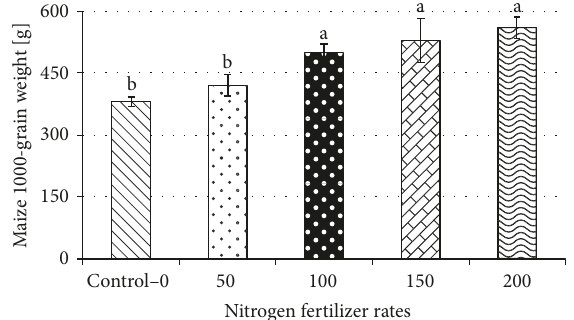
Figure 3: Impact of nitrogen fertilizer rates (control–0, 50, 100, 150, and 200 kg ha −1 ) on maize 1000-grain weight (Mean ± SD). Values across N fertilizer rates with different letters are significantly different ( P < 0.05).